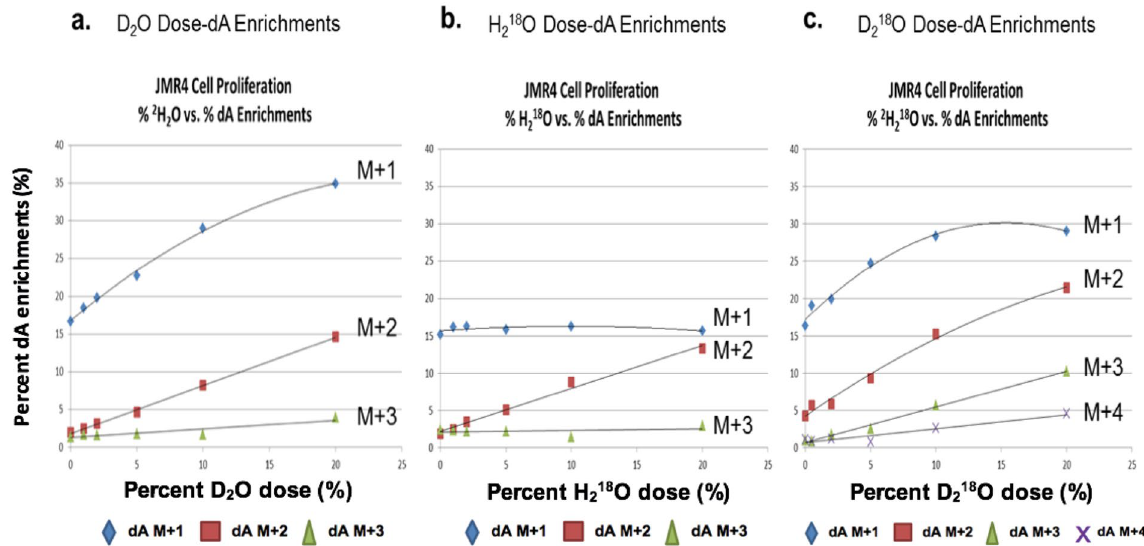
Figure 5. Heavy water dose-dA isotopic enrichments for mouse thymus tumor cell DNA dA M + 1, M + 2, M + 3 and M + 4 isotopologues after 4-day incubation. ( a ) Isotopic enrichments into the DNA dA isotopologues (M + 1, M + 2, M + 3) from mouse thymus tumor cells incubated in cell media fortified using 1 to 20% D 2 O, (v/v). ( b ) Isotopic enrichment into the DNA dA isotopologue (M + 2) from tumor cells incubated in cell media fortified using 1 to 20% H 218 O, (v/v). ( c ) Isotopic enrichments into the DNA dA isotopologues (M + 1, M + 2, M + 3, M + 4) from tumor cells incubated in cell media fortified using 1 to 20% D 218 O, (v/v).